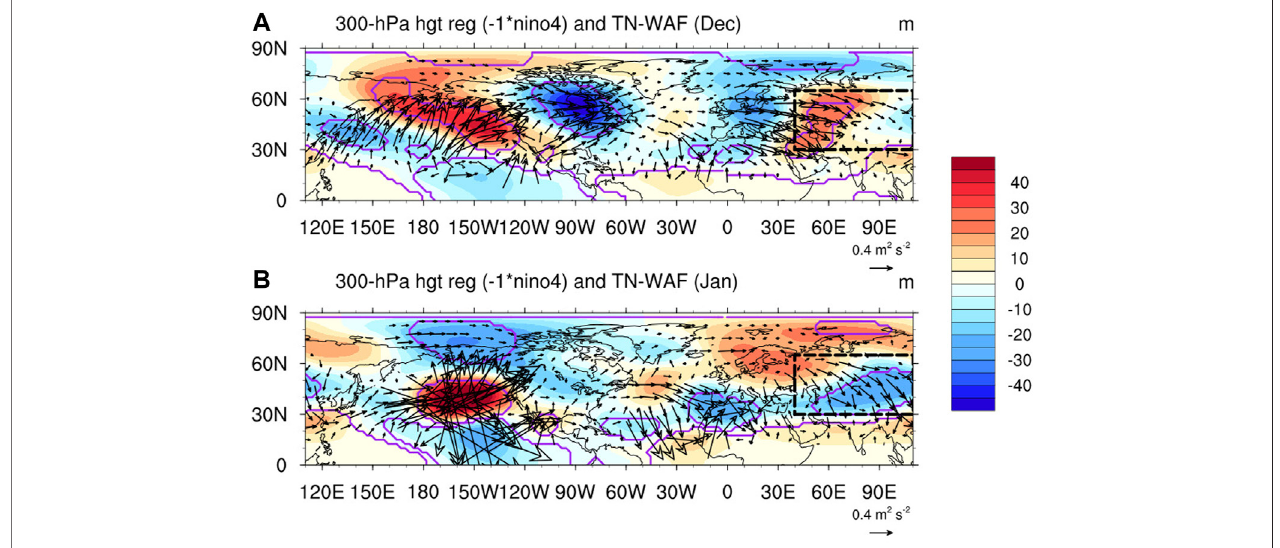
FIGURE 6 | (A) Regression of December 300 hPa geopotential height (shading; m) onto the − Niño4 for the period 1979 – 2017; and the associated horizonal components of the wave activity fl ux (vectors; m 2 s − 2 ) (B) As in (a) but for January during 1980 – 2018. Anomalies signi fi cant at the 95% con fi dence level are denoted by purple contour lines, as estimated by the Student ’ s t- test.